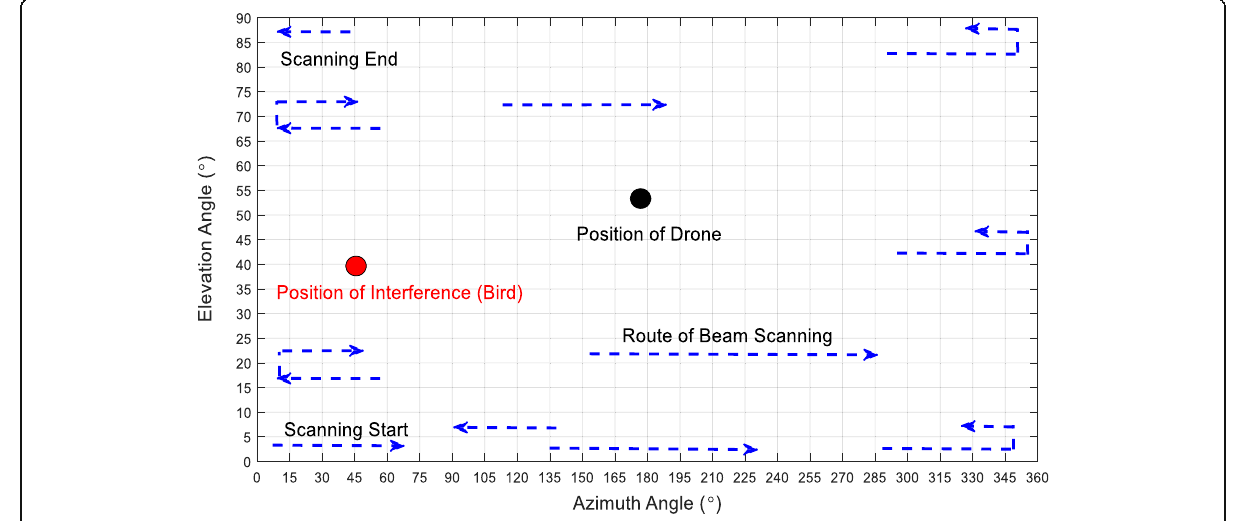
Fig. 4 Scanning resolution and the routes of sound source scanning by